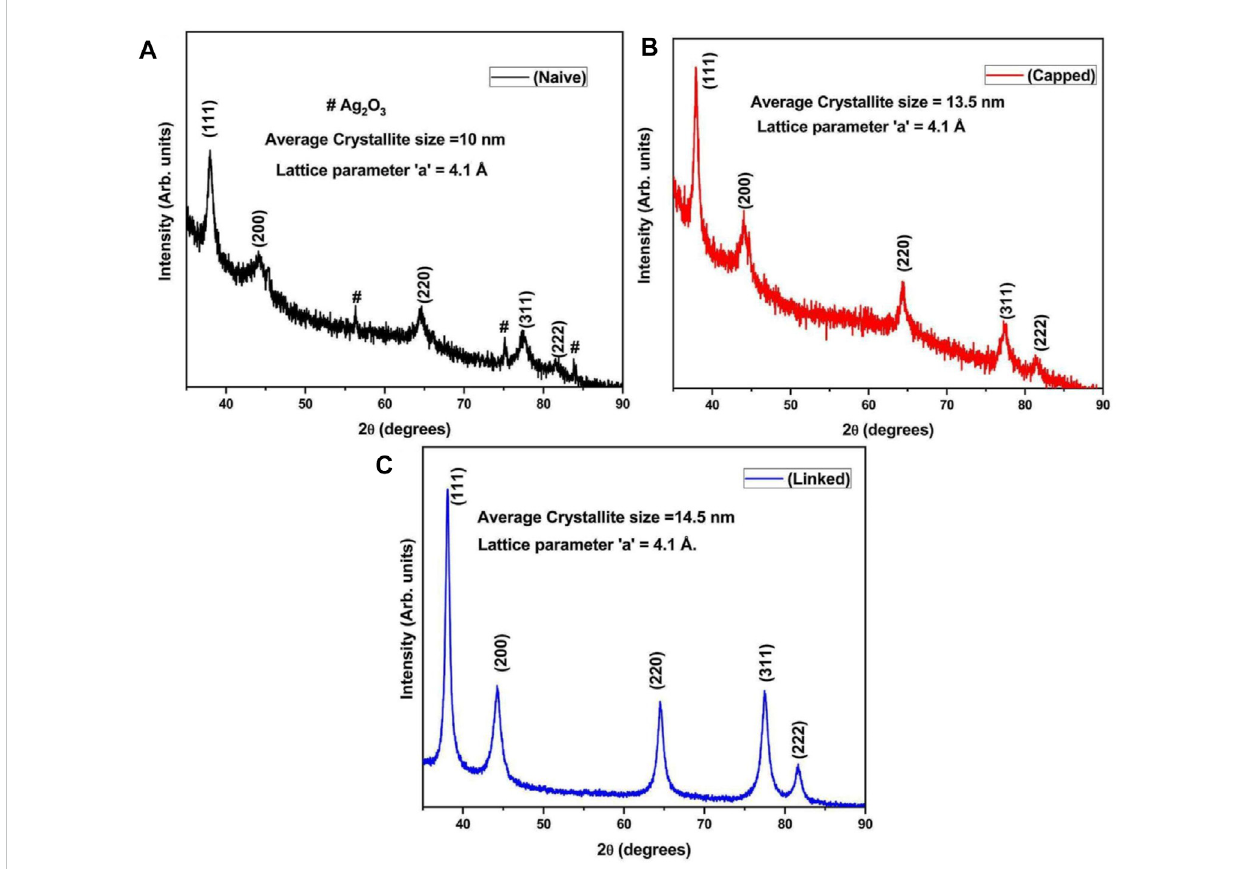
FIGURE 6 Characterization using powder-XRD with (A – C) XRD analysis showing angular diffraction peaks at 2 θ valuesof 38.16 ° , 44.31 ° , 64.41 ° , and 77.50 ° with interplanarspatialre fl ectionsofthefcccrystallatticeatthe(111),(200),(220),and(311)setofplanesfornaive,capped,andlinkedAuNPs.Diffractionpeaks at56.32 ° , 75 ° , and83.5 ° correspondingto theorthorhombic phaseof Au 2 O 3 with spatial re fl ections ofthefcc crystal lattice atthe(711),(113),and (333)set ofplanesfornaiveandcappedAuNPs.Theparametersofthecrystallatticewereobtainedat4.1 Å,4.1 Å,and4.09 Å at10 nm,13.5 nm,and14.5 nm,